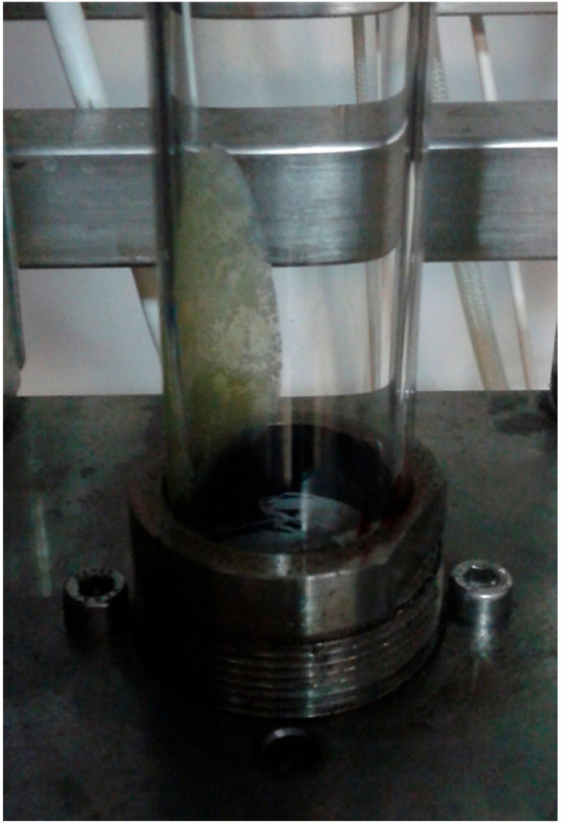
Figure 5. Sulfur deposit on the reactor’s wall.